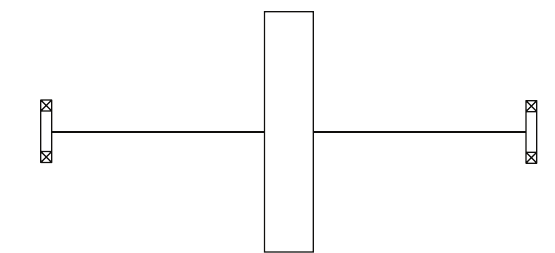
Figure 3: FE-model supported by pedestals with clearance.